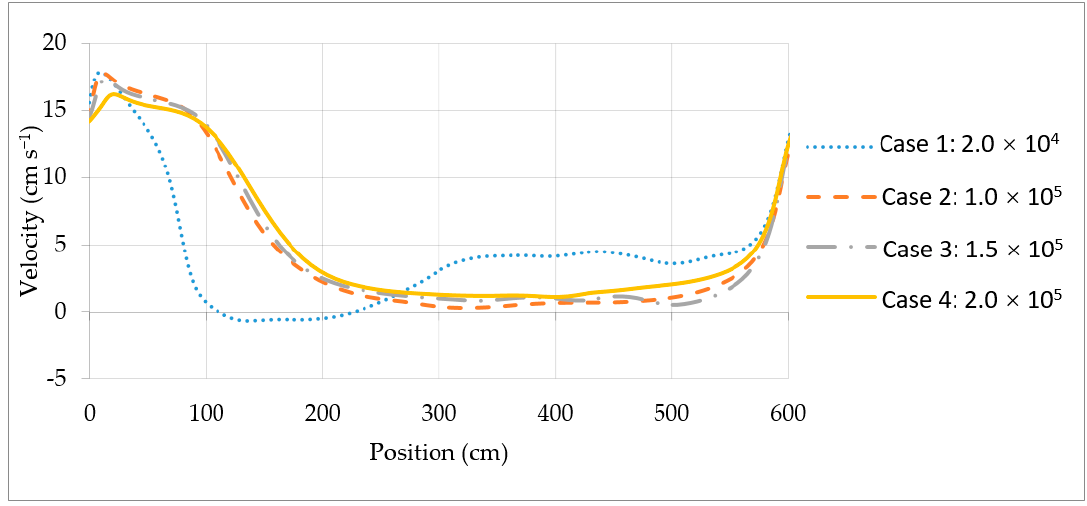
Figure 1. Grid convergence for different cell sizes.